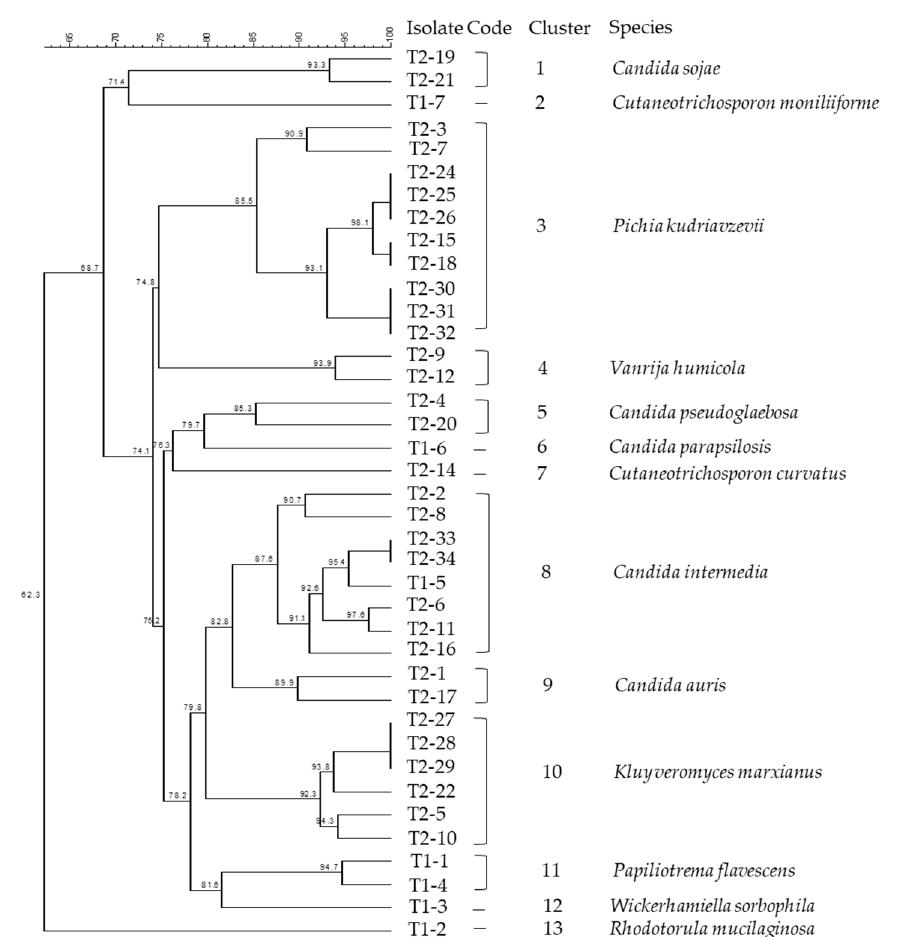
Figure 2. Dendrogram of (GTG) 5 -PCR fingerprints of yeast isolates collected from the production line of white-brined cheese. Clustering was based on Dice’s coefficient of similarity with the unweighted pair-group method with arithmetic average clustering algorithm (UPGMA). Numbers of nodes in the dendrogram denote the percentage of similarity between the clusters.